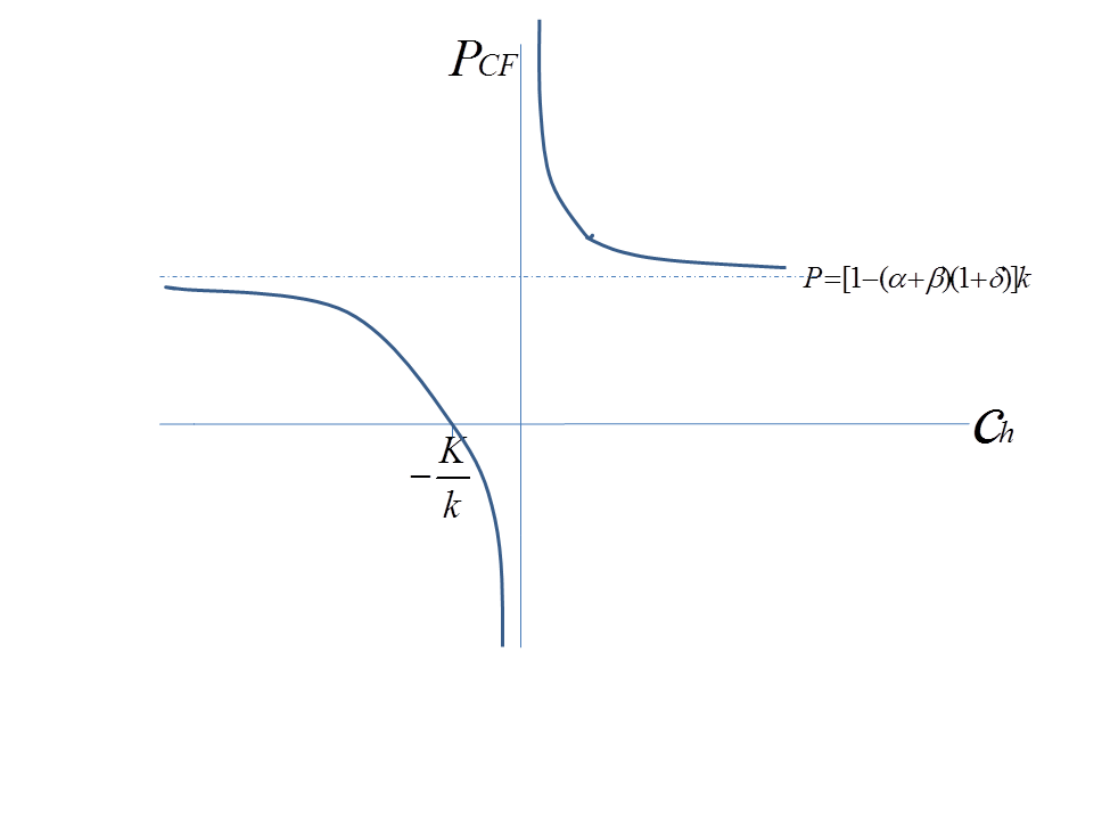
Figure 3: The optimal price for CF and the